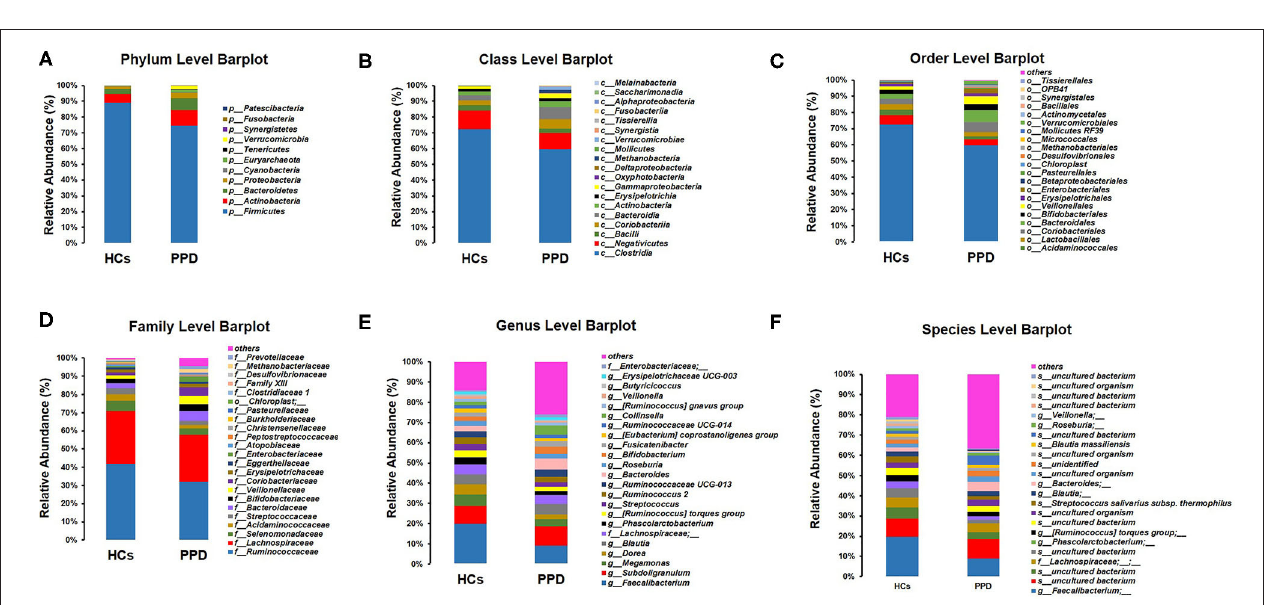
at the genus level according to the relative abundance ( Figure 4E, Table 3 ). Among all bacteria, g_Faecalibacterium was the most dominant one, accounting for 19.79% in HC group and 9.22% in the PPD group. The prominent changes of community structure of the gut microbiota at the genus level are related to the decrease of g_Faecalibacterium ( P = 0.003), g_Phascolarctobacterium ( P = 0.022), g_Butyricicoccus ( P = 0.024), and g_Megasphaera ( P = 0.047) in the PPD group compared to those in the HC